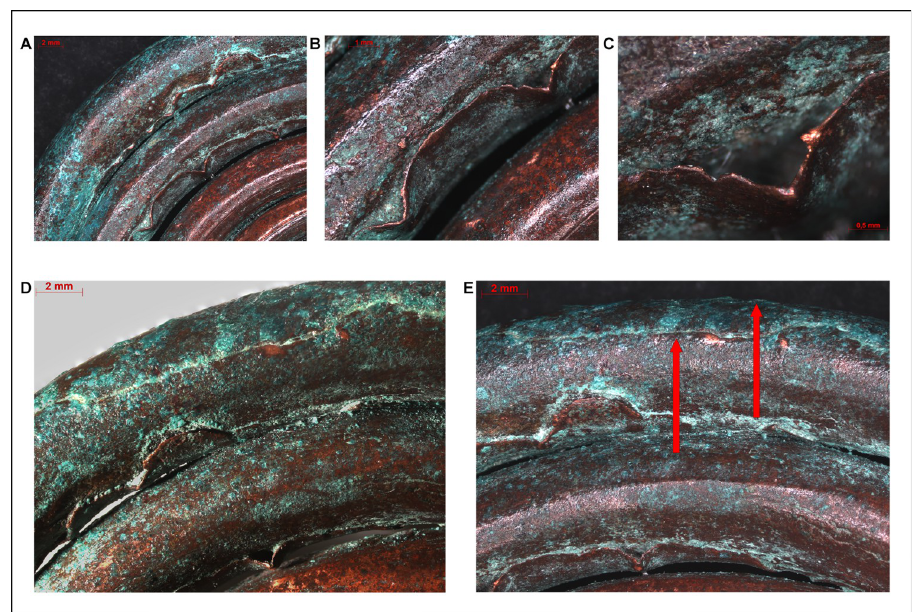
Fig 13. Micrographs showing the macrostructure of the spectacle spiral pendants. Photo: Eszter Horva´th. (A–C) The outer edges of the laminated and rolled copper sheets were creased due to the coiling (O˝.2019.8.1.182). (D–E) The outer edges of the laminated and rolled copper sheets shifted a few millimetres off the central axis of the coil (O˝.2019.8.1.182). Red arrows are showing the final, cover sheet with edges facing each other (running in opposite directions).